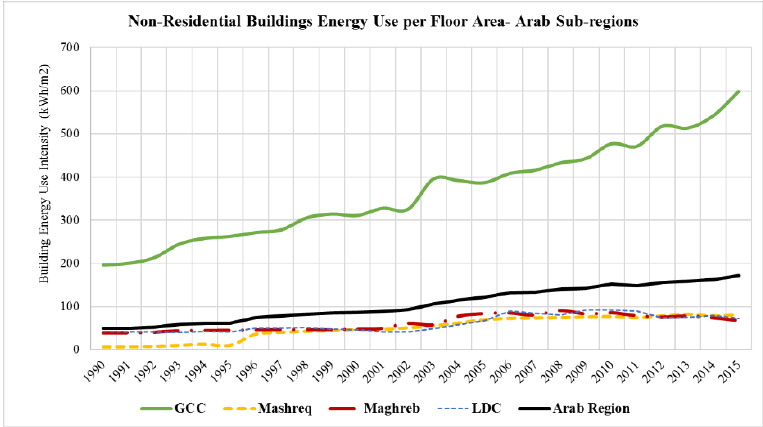
Figure 19. Annual non-residential buildings energy use intensity of the Arab sub-regions during the 1990–2015 period. Table 12. Reported EUI values for non-residential buildings in select Arab countries.